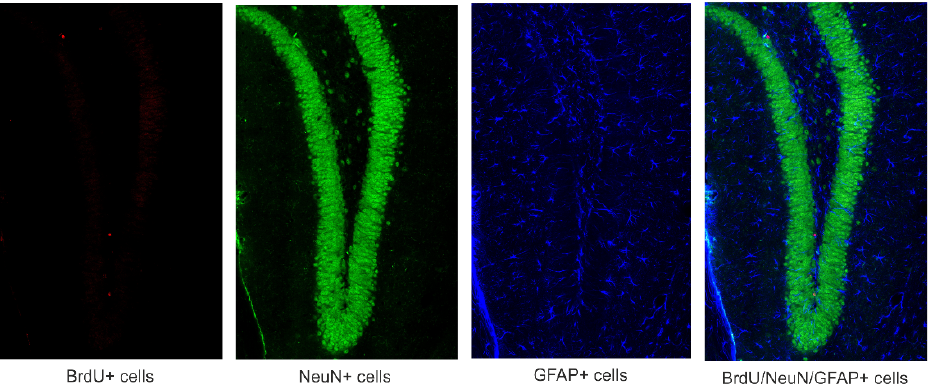
Figure 1. A representative image of BrdU positive cells in colocalization with neurons (NeUN) and astrocytes (GFAP).